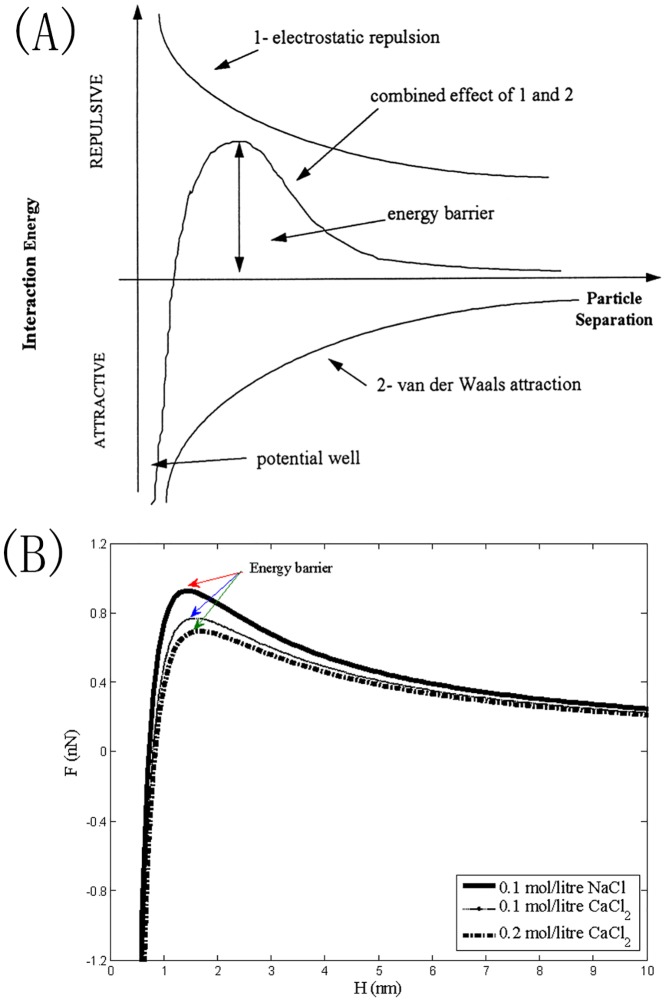
RepresentationofDLVOtheory, (A) a schematic diagram incited from Thomas et al. (1999) [5]; (B) a diagram for the cases with 0.1mol/litre NaCl, 0.1mol/litreCaCl2, and 0.2mol/litre CaCl2, added into the suspension.